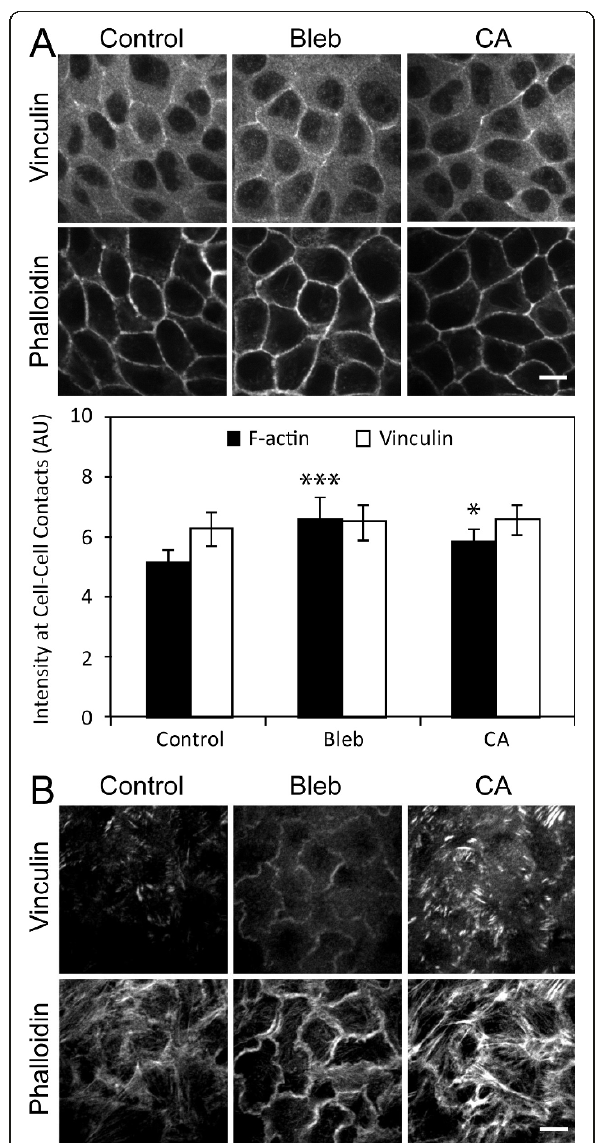
Figure 4 Myosin II activity and vinculin recruitment to cell-cell contacts of MDCK cells . (A) Confluent MDCK cell monolayers on collagen-coated coverslips were incubated with media containing 50 μ M blebbistatin (Bleb), 10 nM calyculin-A (CA), or media alone (Control) for 1 hr. Cells were fixed and immunostained for vinculin or F-actin (phalloidin) at cell-cell contacts. The same exposure and laser power were used to acquire and generate the images. Scale bar 10 μ m. Data of immuno-fluorescence intensities and analysis of F-actin and vinculin at cell-cell contacts are presented as mean ± standard deviation and are compared with control (n = 10, *P < 0.05, ***P < 0.001). (B) Immuno-fluorescence of vinculin and F-actin at basal level of confluent MDCK cells. Scale bar 10 μ